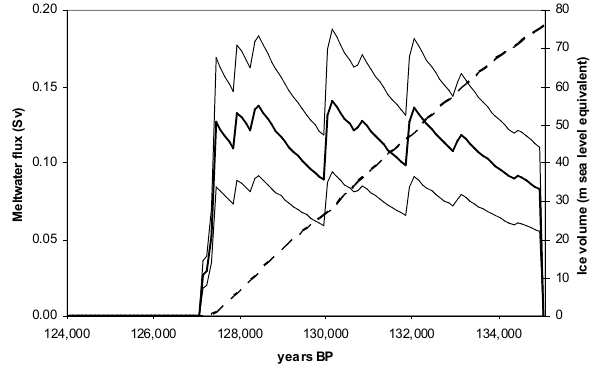
Fig. 3. Representation of ice sheets in the TII ensembles. The global distribution of ice sheets is given by Equation 1, assuming a constant reduction of δ 18 O from 4.86 to 3.16‰ from 135000 to 126000BP. Meltwater is calculated at each grid cell and routed to the ocean assuming modern day topography. The dashed line illus- trates total Laurentide and Eurasian ice sheet volume, expressed in equivalent meters of sea-level. The solid lines illustrates the profile of ensemble mean meltwater flux (bold, FFX=1.5) and the range of meltwater fluxes (FFX=1.0 to FFX=2.0). The temporal devel- opment of meltwater is fixed across all ensemble